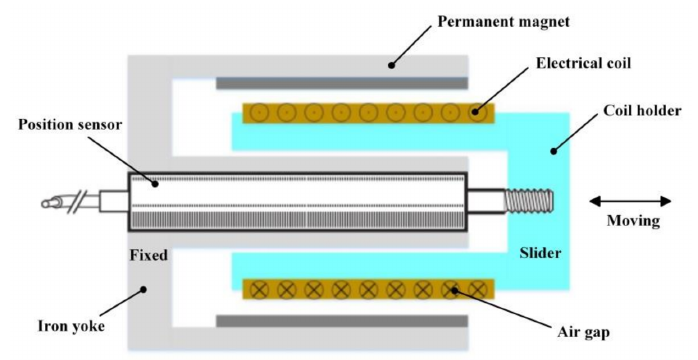
Figure 2. Principle of voice coil motor with position sensor.